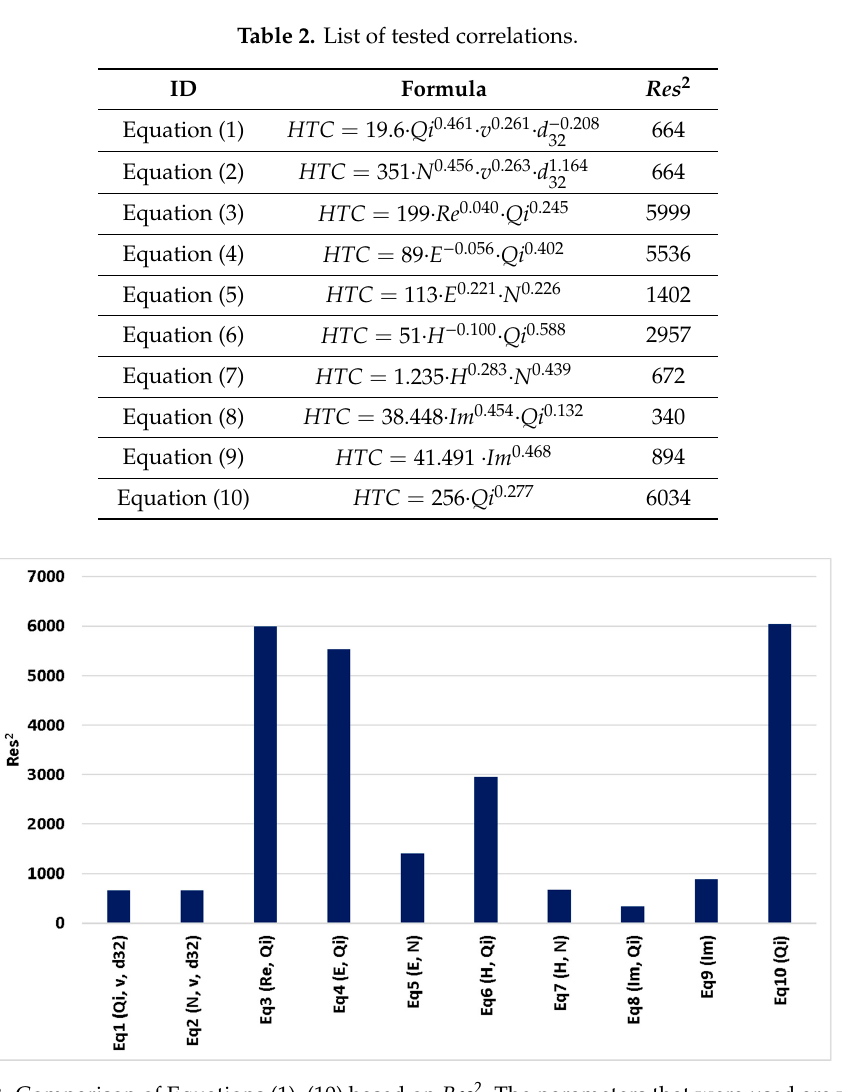
Figure 13. Comparison of Equations (1)–(10) based on Res 2 . The parameters that were used are written under each column.